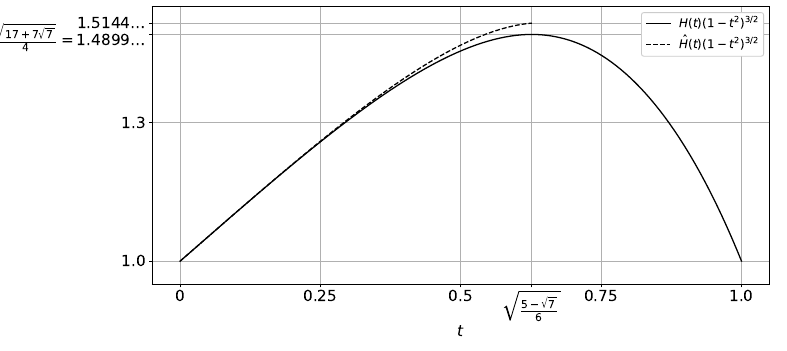
Figure 2. Plots of the functions H ( t )( 1 − t 2 ) 3/2 and ˆ H ( t )( 1 − t 2 ) 3/2